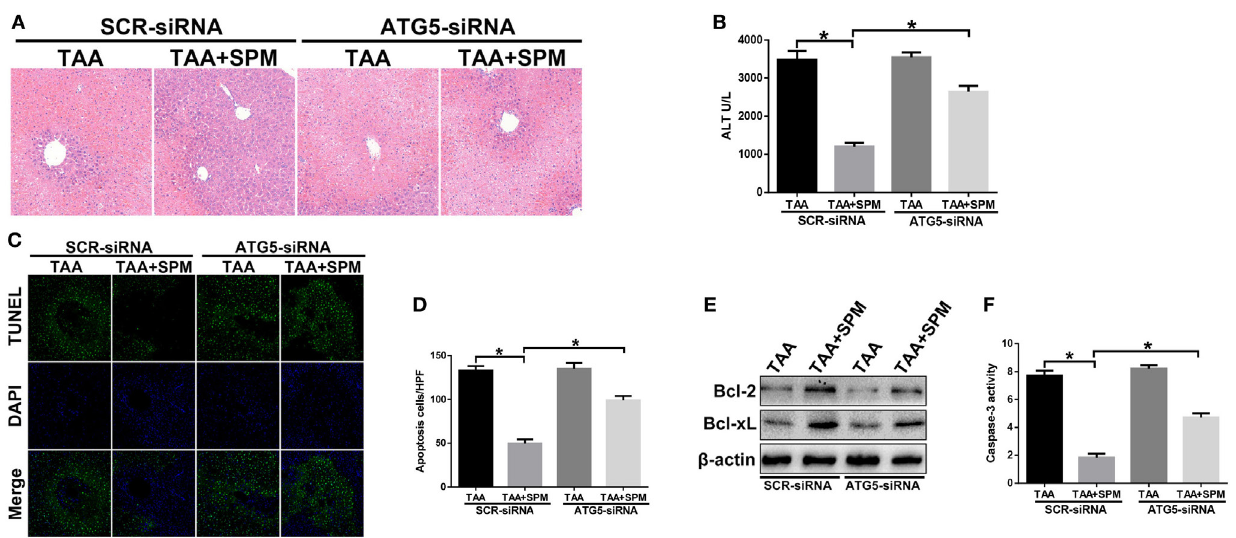
FigUre 6 | Spermine (SPM) attenuates thioacetamide (TAA)-induced acute liver injury by promoting KC autophagy. Mice were subjected to SPM pretreatment and TAA administration as described in Section “Materials and Methods.” Both TAA and TAA + SPM mice were pretreated with ATG5 siRNA (ATG5-siRNA) or its scrambled control siRNA (SCR-siRNA) in vivo prior to TAA administration using mannose-conjugated polymers as described in Section “Materials and Methods.” Liver injury was evaluated in terms of liver histopathology [ (a) , representative of six mice/group] and serum alanine aminotransferase (ALT) levels [ (B) , n = 6/group]. TUNEL staining of liver sections (original magnification 20 × ). DAPI was used for nuclear staining. Representative of six mice/group (c) . Ratios of TUNEL-positive cells in different experimental groups [ (D) , n = 6/group]. Bcl-2, Bcl-xL, and β -actin protein levels were measured by Western blot. Representative of three experiments (e) . Cellular activity was determined by caspase-3 activity assay. Representative of three experiments (F) (* p <